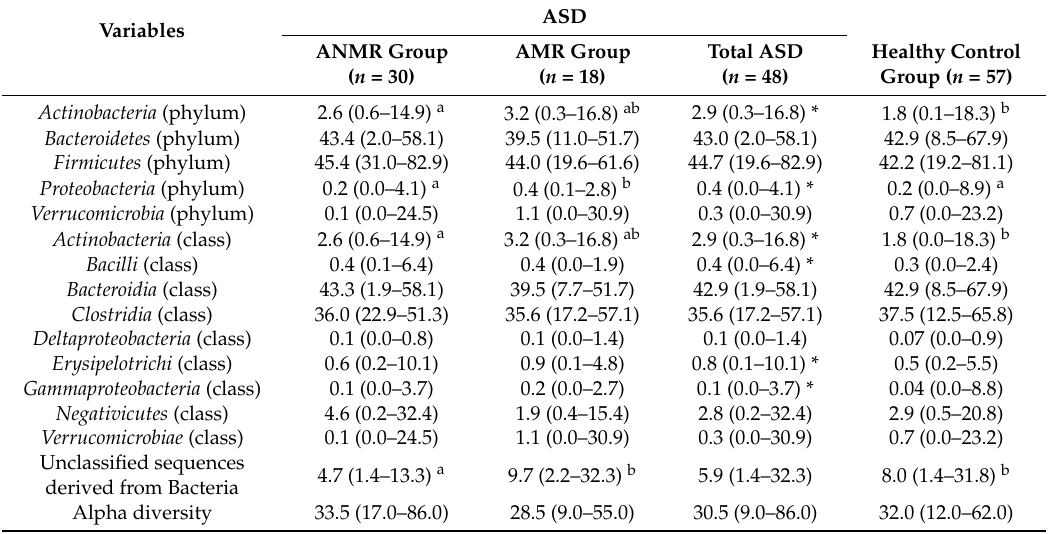
Table 2. Relative abundances of bacteria in fecal microbiota of children with ASD and healthy children.